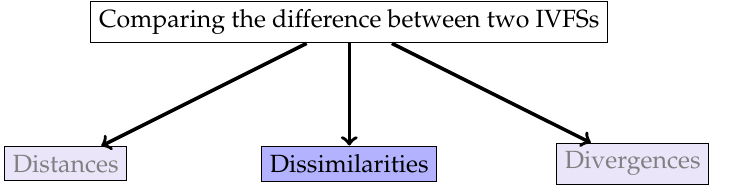
Figure 18. Suitable way to compare